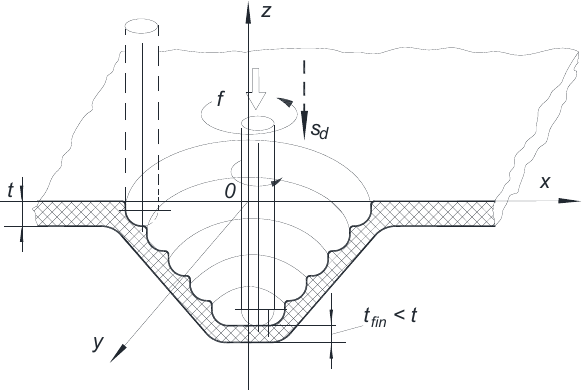
Figure 1. Gradual generation of the conical surface from the polycarbonate sheet by single-point incremental forming.